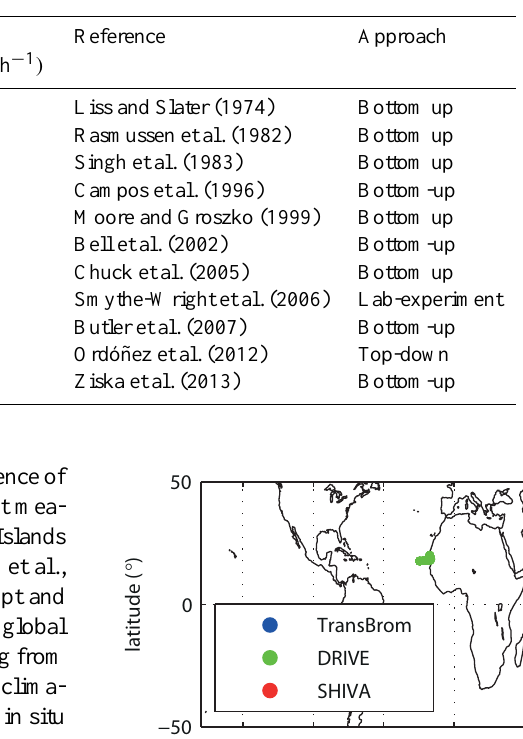
Table 1. Global CH 3 I emission estimates in the literature given in GgIyr − 1 and additionally in pmolCH 3 Im − 2 h − 1 .